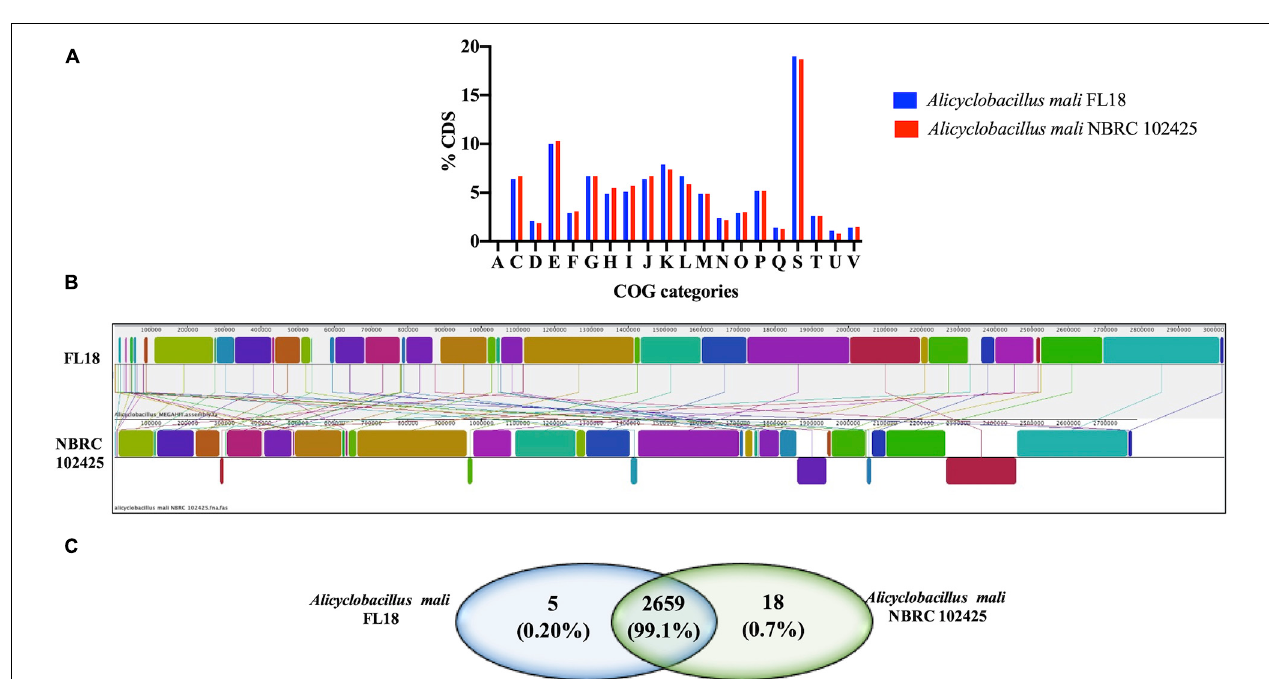
FIGURE 5 | Genome comparison between A. mali FL18 and NBRC 102425. (A) COG comparison of A. mali FL18 (blue) and A. mali NBRC 102425 (red). (B) Mauve progressive alignment of FL18 and NBRC 102425. (C) Venn diagram showing the number of shared and unique proteins.